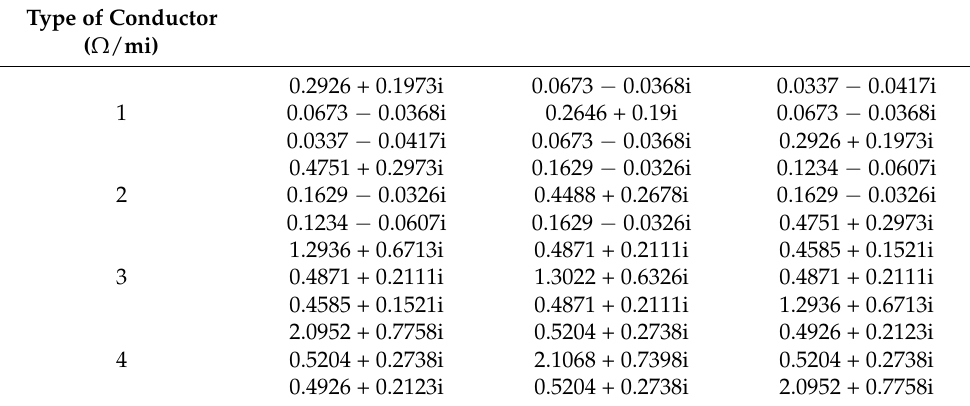
Table A6. Impedance matrix for the type of conductors in the IEEE 37-node